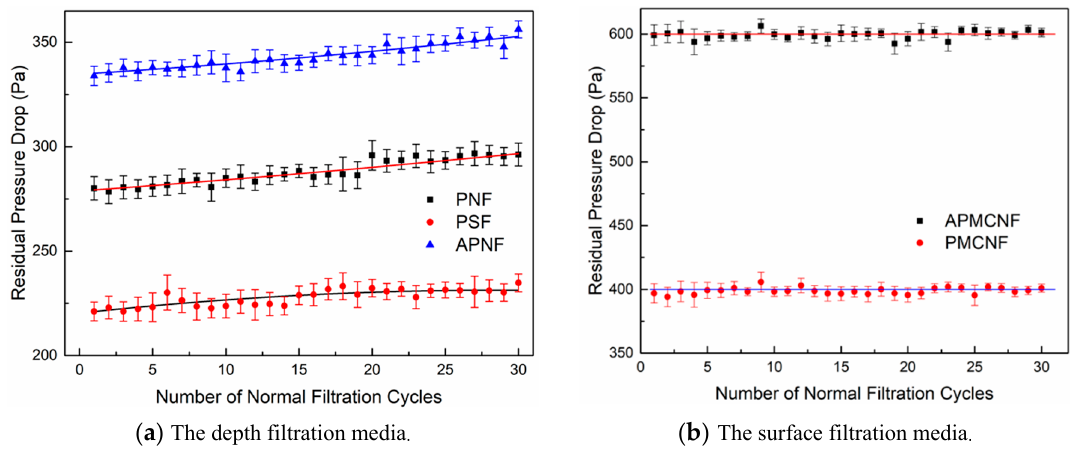
Figure 11. The changes in the residual resistance drop of the five filter media in the fabric recovery period.